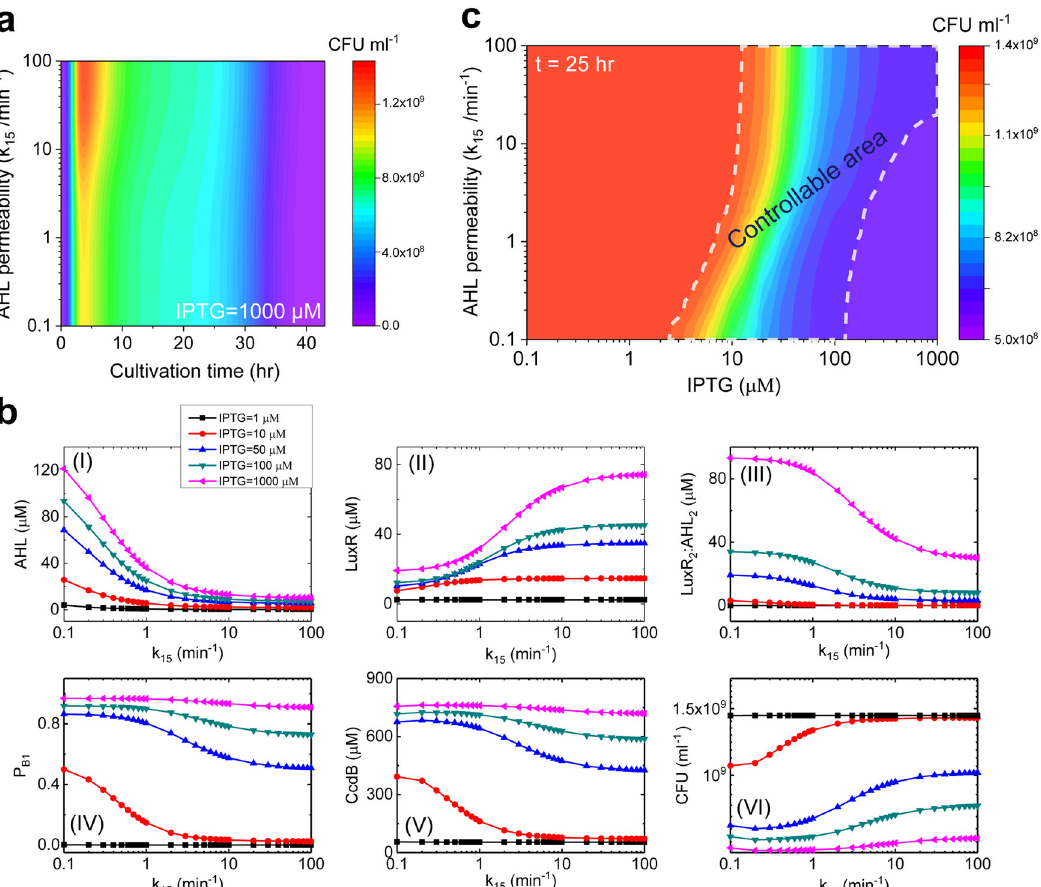
Fig. 4 Role of AHL permeability in controlling bacteria population density. a Change of bacteria-growth curve under different permeability of AHL ( k 15 ) with 1000 μ M IPTG induction. b Dynamic responses of the key components under different permeability of AHL with various IPTG induction doses during the stationary phase. c Change of population density under different permeability of AHL with a series of IPTG induction doses during the stationary